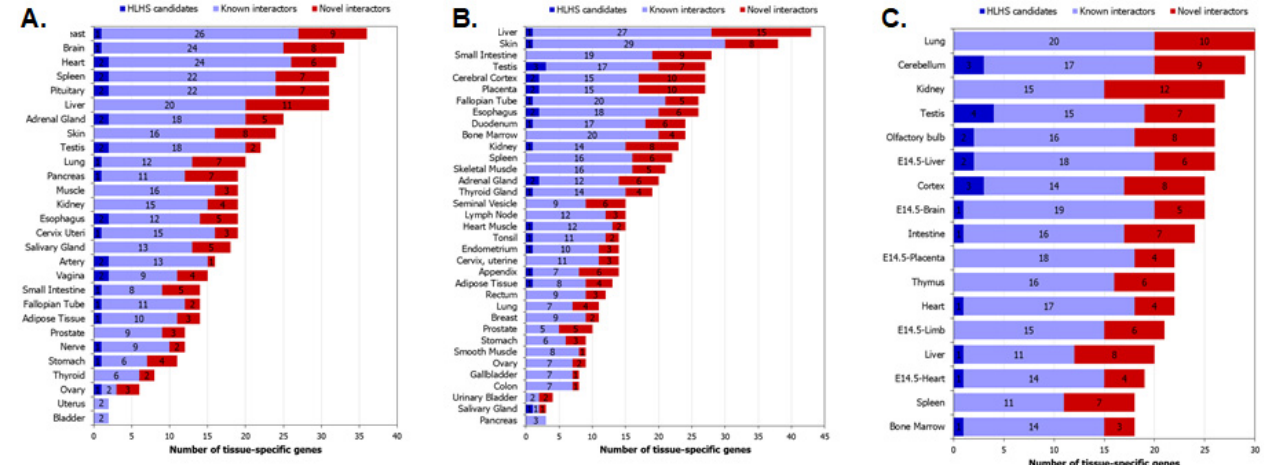
Figure 7. Tissue-specificity of hypoplastic left heart syndrome (HLHS) interactome genes: The graphs show the number of genes from the interactome that exhibit tissue-specificity according to data from ( A ) GTEx, ( B ) Human Protein Atlas and ( C ) mouse ENCODE. The genes show at least 5-fold higher expression in a tissue (‘tissue-enriched’) or a group of 2–7 tissues compared to all the other tissues (‘group-enriched’).